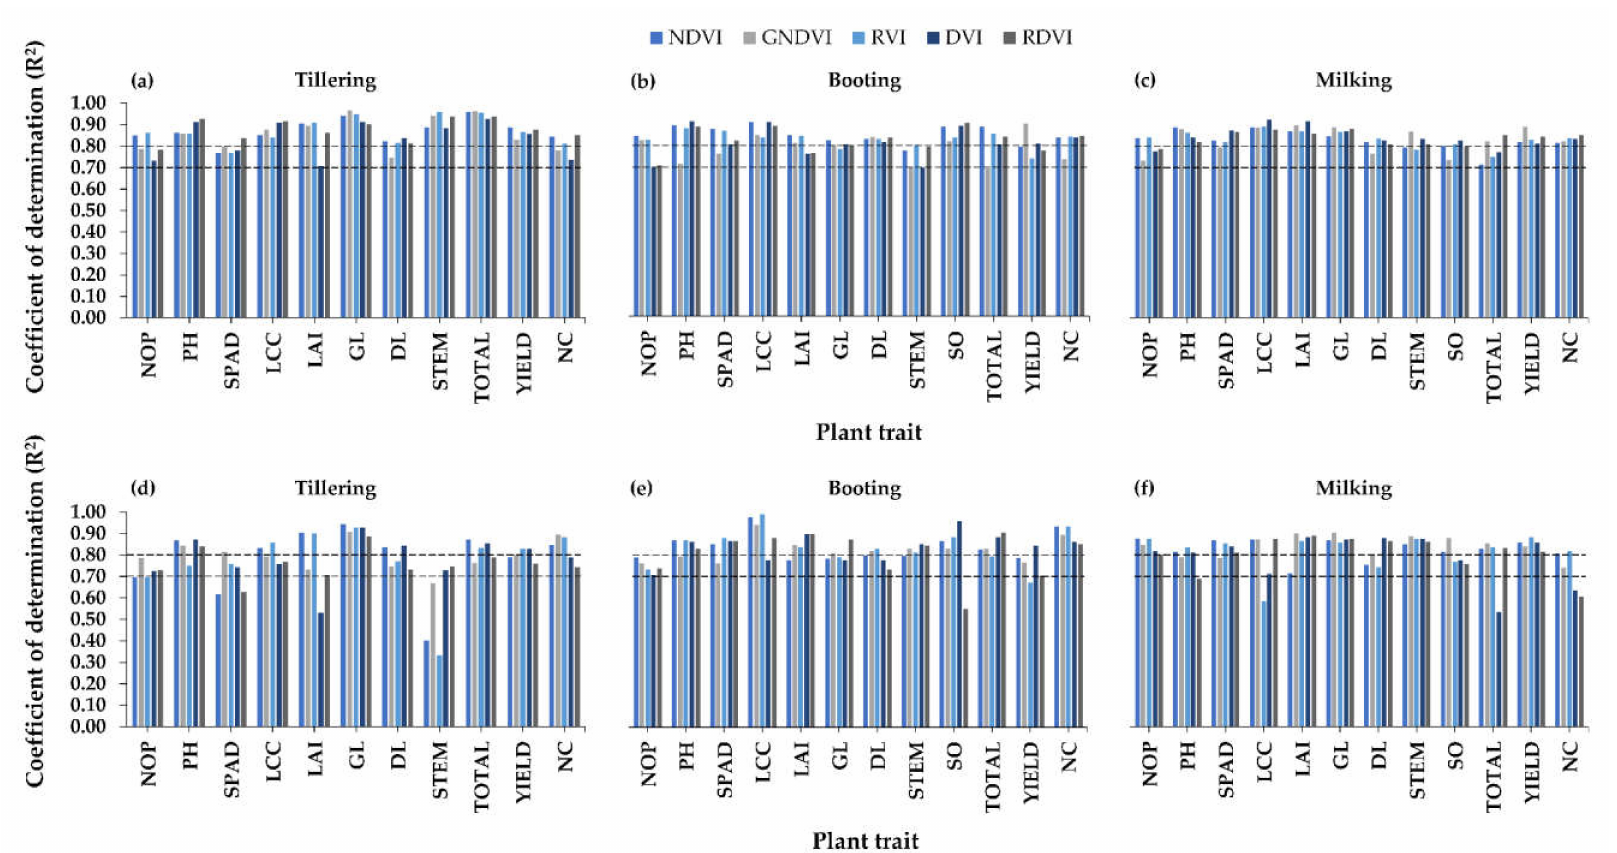
Figure 4. R 2 values for the visible-NIR indices’ training ( a – c ) and testing ( d – f ) models for all plant traits at different rice growth